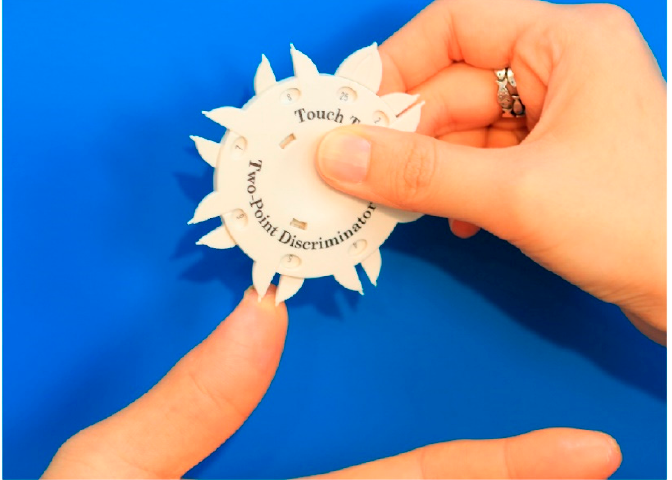
Figure 2. The two-point discrimination test (2-PDT). To perform the 2-PDT, the evaluator touches the patient’s fingertip with the two-point discriminator device, randomly alternating between one and two points. The patient is asked to report whether one or two points were felt.